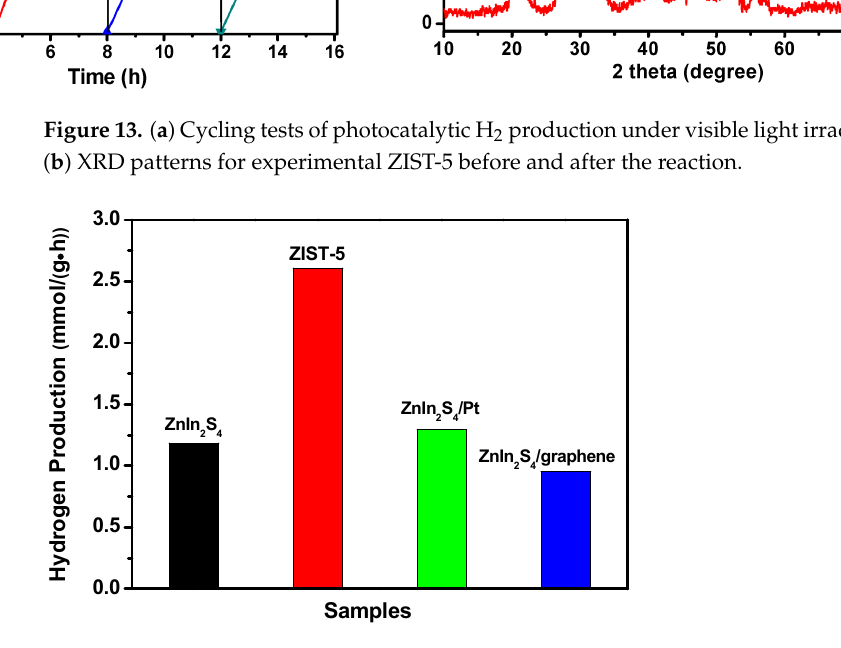
Figure 14. Rate of H 2 evolution of ZnIn 2 S 4 , ZnIn 2 S 4 /Pt, ZnIn 2 S 4 /graphene, and ZIST-5 under visible light irradiation.